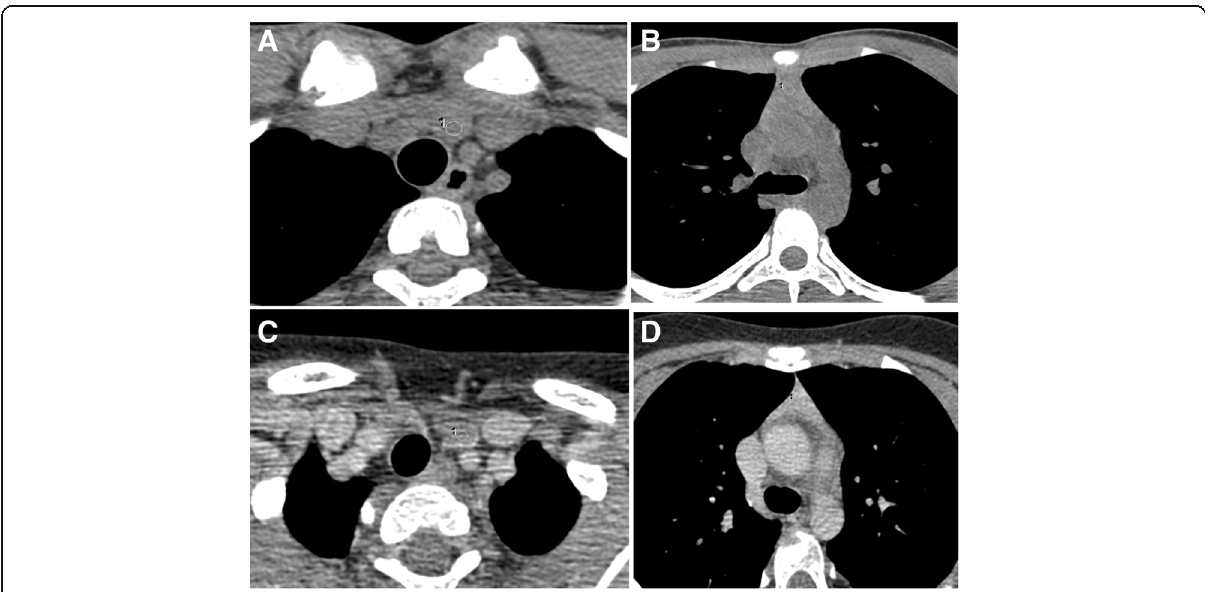
Fig. 2 a , b Non-contrast CT images of neck and thorax of a 15-year-old male patient. c , d Contrast CT images of neck and thorax of a 10-year-old female patient. a Cervical thymus shows density of 35 HU on non-contrast CT. b Mediastinal thymus shows density of 61 HU on non-contrast CT. c Cervical thymus shows density of 46 HU on post-contrast CT. d Mediastinal thymus shows density of 100 HU on post-contrast